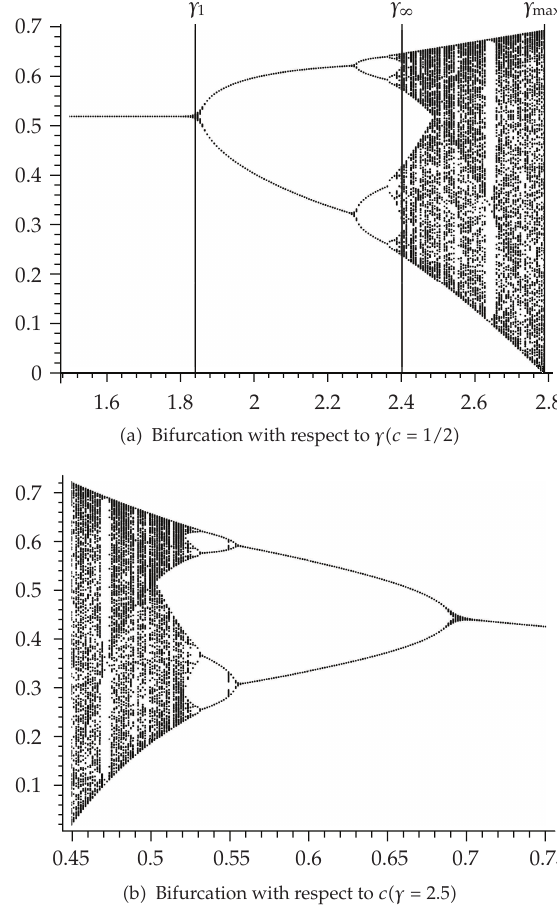
Figure 2: Bifurcations of x t (cid:6) f (cid:2) x t − 1 (cid:3) , m (cid:6) 3